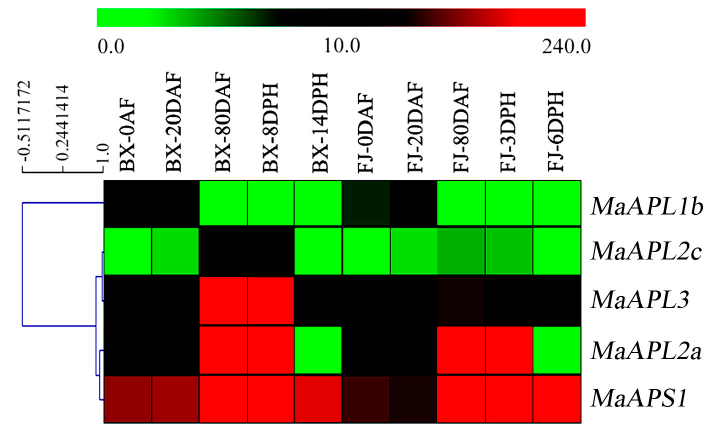
Figure 5. Expression of MaAGPases during different stages of fruit development and ripening in two banana varieties, BX and FJ. The heat map with clustering was created based on the FPKM value of the MaAGPases . Differences in gene expression changes are shown in color in the green-red scale.